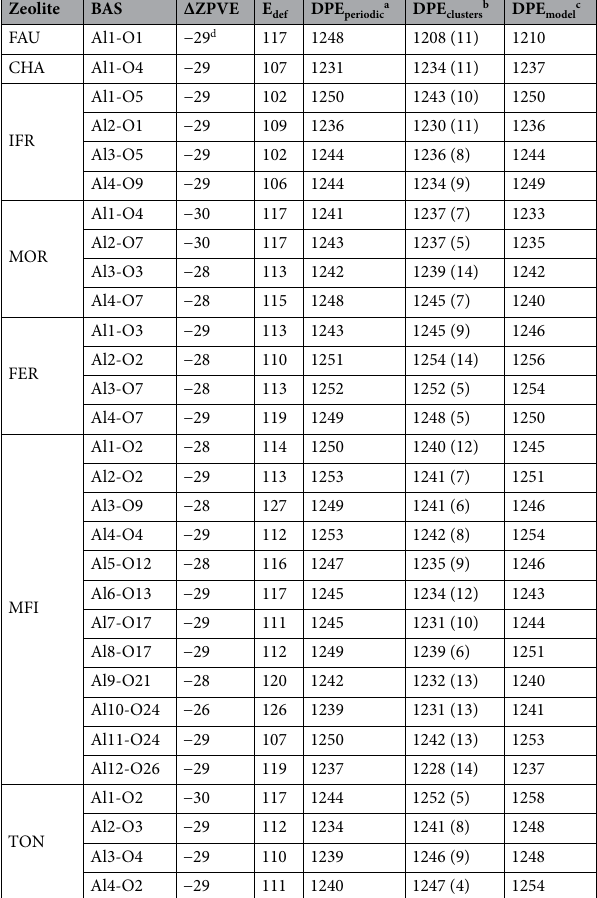
Table 1. The deprotonation energy (in kJ·mol -1 ) for most stable BAS along with correction to zero-point vibrational energy and anion deformation energy (in kJ·mol -1 ) from periodic model calculations. a See Eq. (1), vertical shift is set to 1243 kJ·mol −1 to yield same mean value as DPE model . b See Eqs. (2–3), averaging is performed for cluster 9 T onward (see Figure S4) and standard deviation is given in paratheses. c See Fig. 3